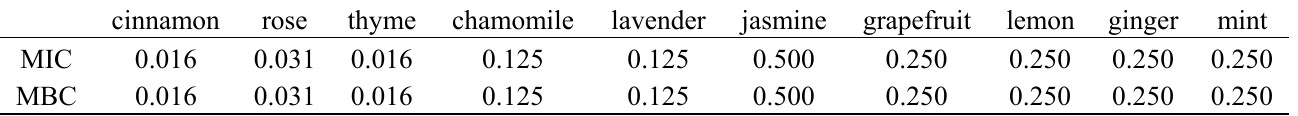
Table1. Minimal inhibitory concentrations (MICs, %v/v) and minimal bactericidal concentrations (MBCs, %v/v) of 10 essential oils towards P. acnes